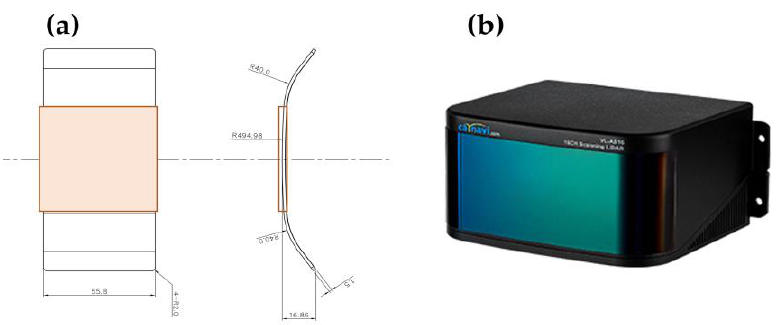
Figure 7. ( a ) Window sample cover dimension; ( b ) target LiDAR (VL-R16).